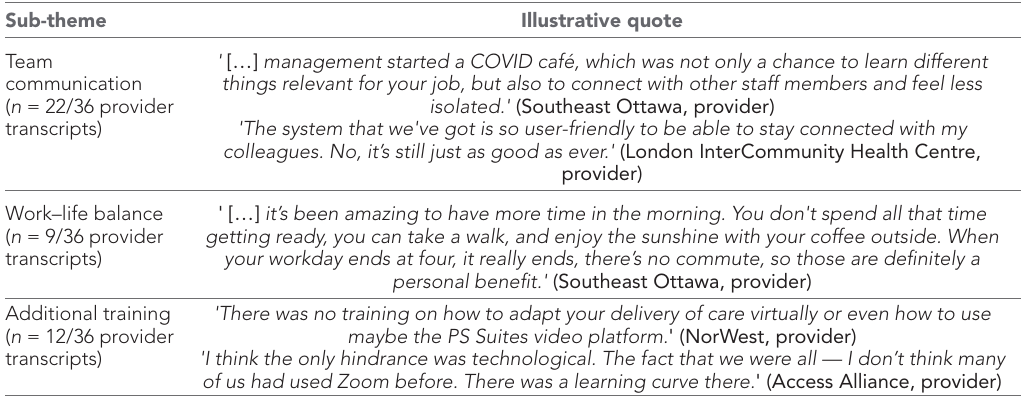
Table 5 Quadruple aim 4: Improving provider